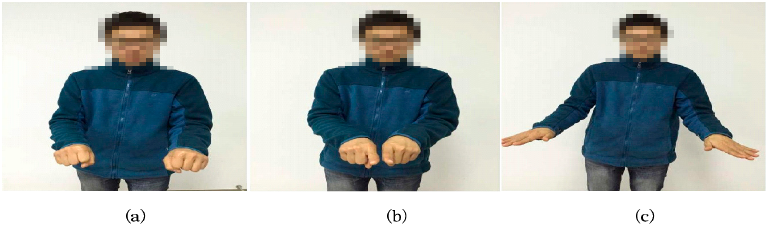
Figure 3. Handshape change during the execution of CSL sign word “object”: ( a ) the beginning stage; ( b ) the middle stage; and ( c ) the end stage. Table 1. The component-based representation of a sign language gesture .